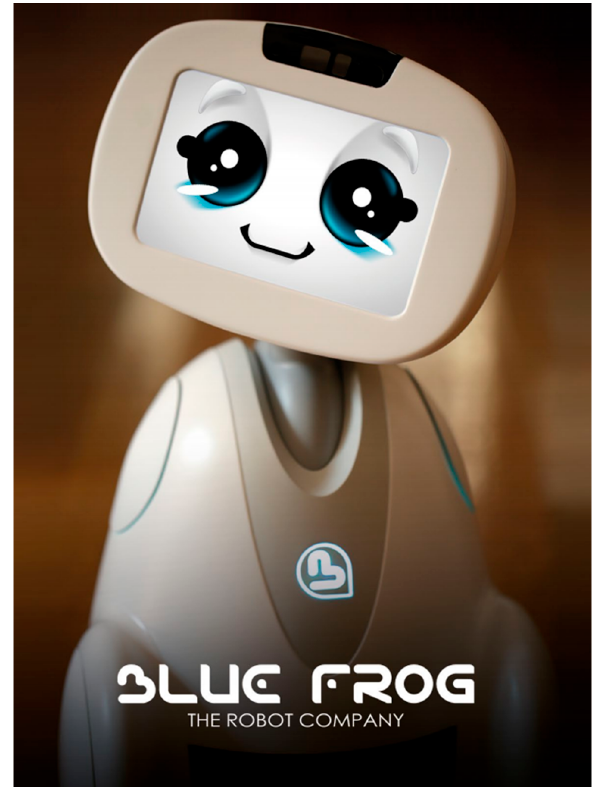
Figure 6. Buddy by Blue Frog Robotics. Taken with permission from the press kit.